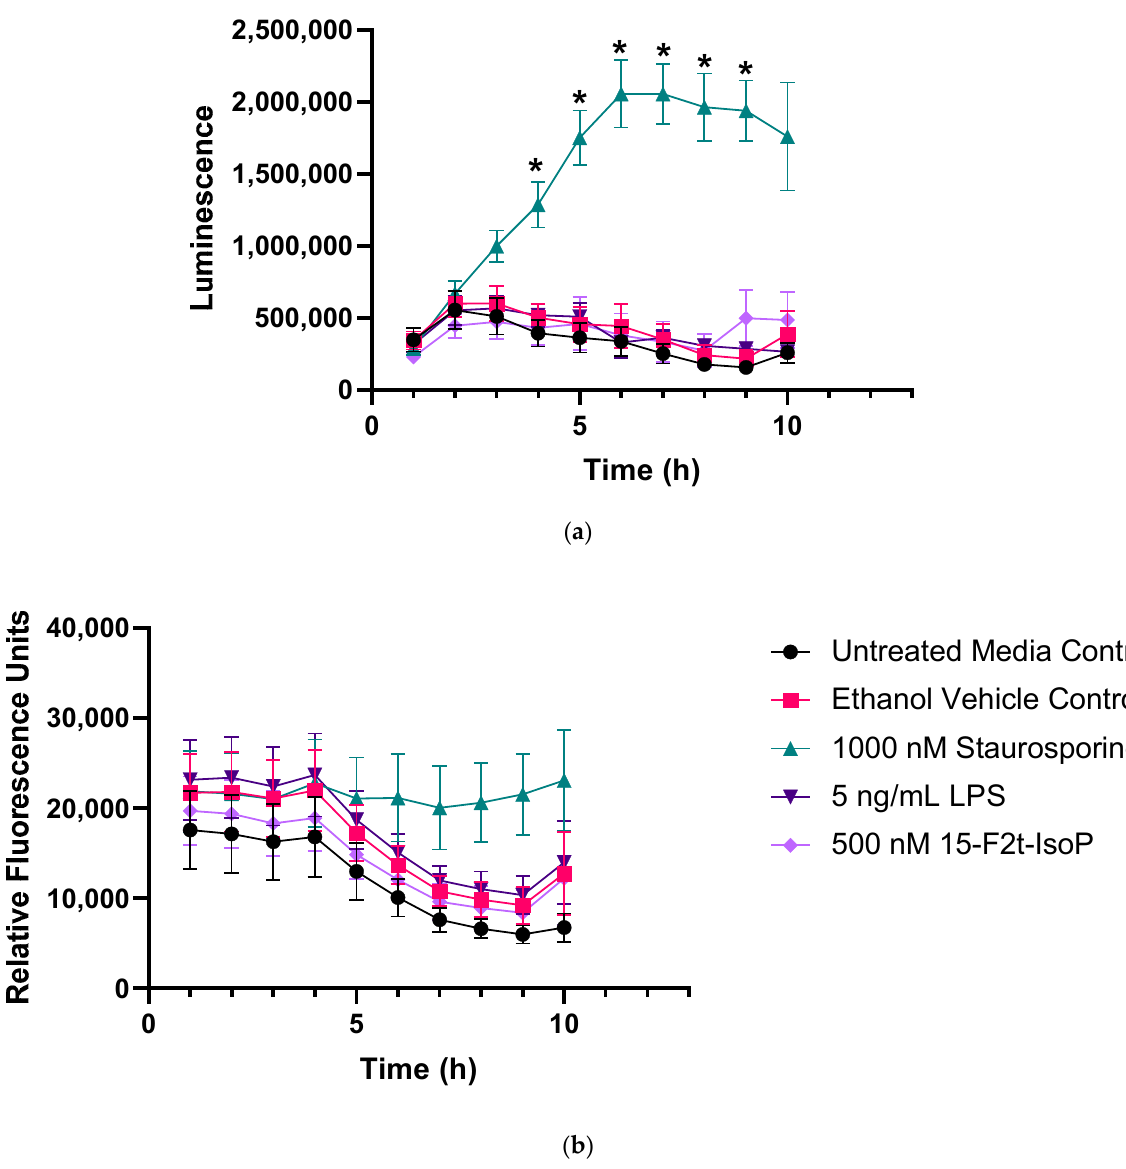
Figure 2. Endotoxin and 15F 2t -Isoprostane do not cause apoptosis or necrosis in RAW 264.7 macrophages ( n = 7). ( a ) Mean luminescence, representative of apoptosis; * increased luminescence in the staurosporine treatment group at a given time point ( p < 0.05). ( b ) Mean fluorescence, resulting from necrosis secondary to apoptosis. Statistical analyses included a linear mixed effects model with Tukey’s HSD posthoc test. LPS—lipopolysaccharide; IsoP—Isoprostane; h—hour.